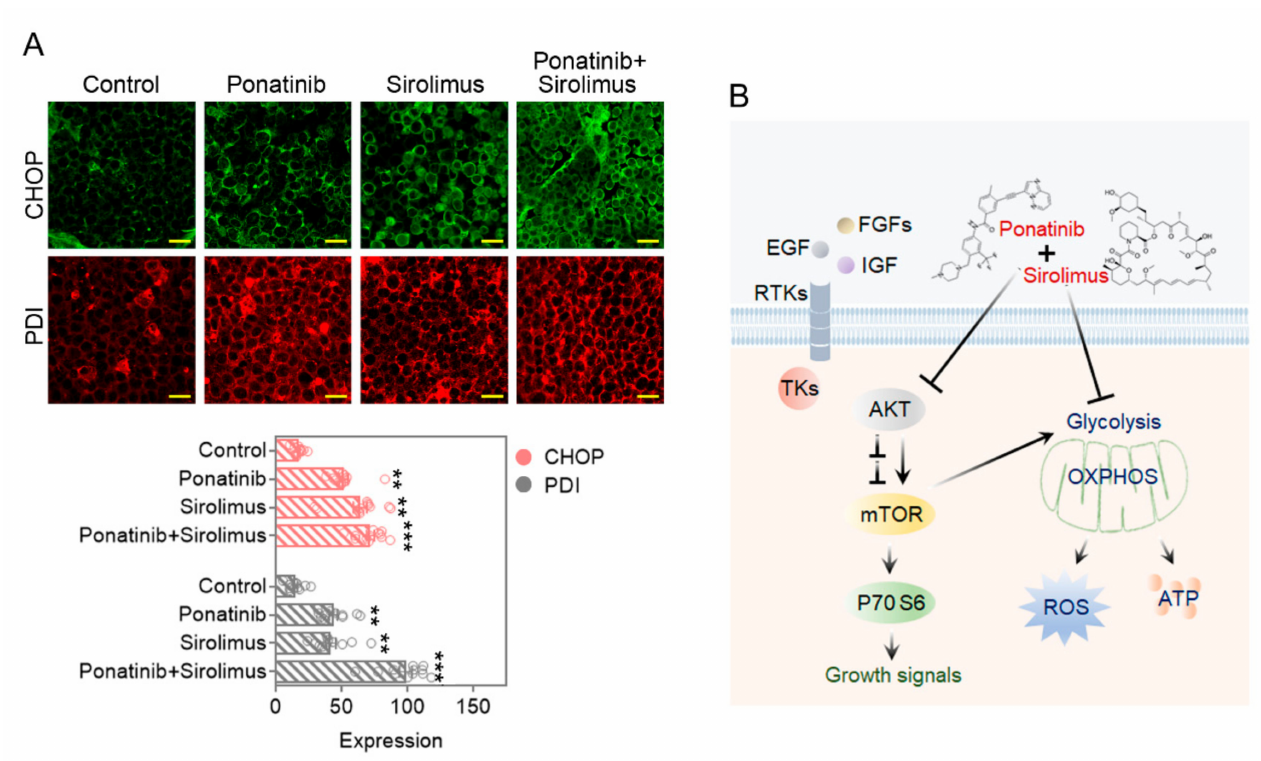
Figure 8. Ponatinib-and-sirolimus combination increases ROS production in multiple myeloma tu- mors. ( A ) Fixed tumor tissue samples were stained with antibodies specific to CHOP and PDI as ROS markers. The fluorescent images were quantified by using ImageJ software and plot- ted as a histogram. Scale bar is 50 µ m. Data are presented as mean ± SEM; t -test: ** p < 0.01, *** p < 0.001. ( B ) Ponatinib-and-sirolimus combination inhibits glycolysis and OXPHOS to inhibit ATP production and increase ROS accumulation; AKT and mTOR signaling/activity was reduced by the drug